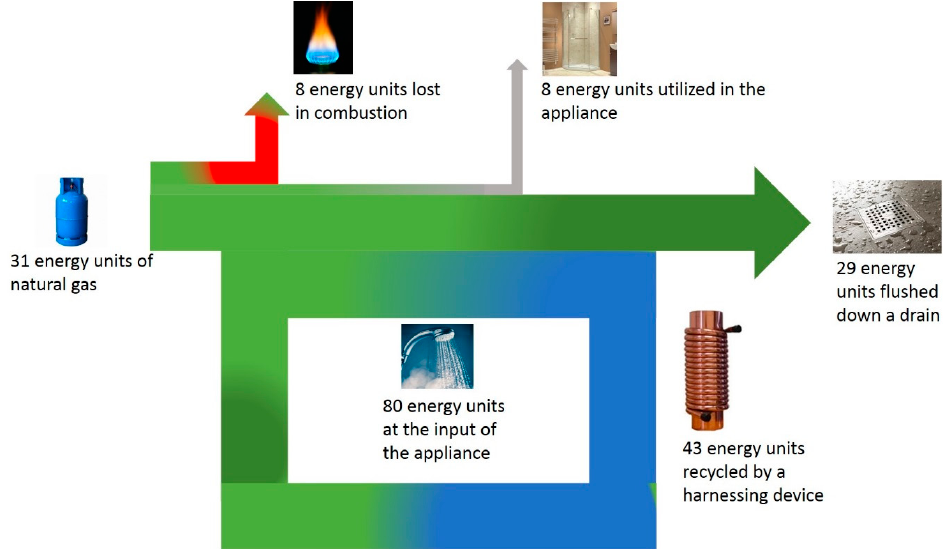
Figure 12. Sample usage cycle in an appliance after heat harnessing.